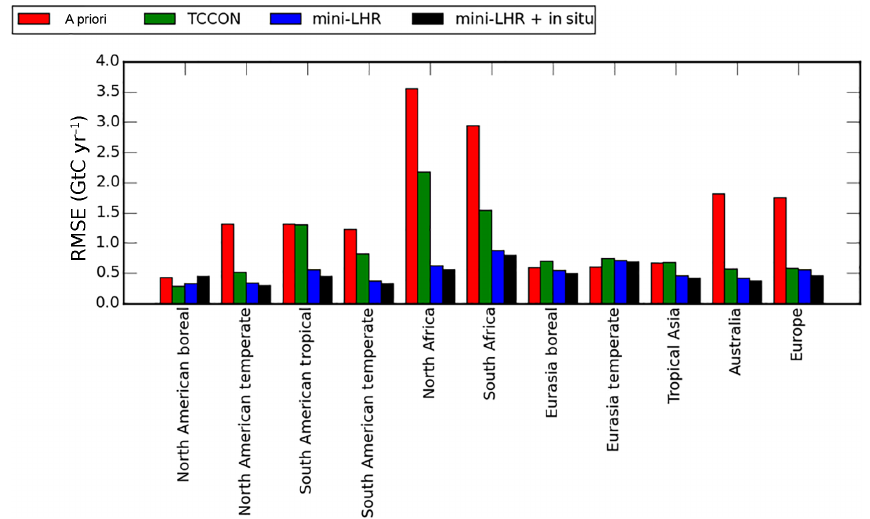
Figure 9. Annual mean root-mean-square errors (RMSEs; GtCyr − 1 ) associated with (red) a priori and a posteriori flux estimates inferred from (green) TCCON and (blue) mini-LHR CO 2 columns and from the (black) combined mini-LHR–NOAA in situ flask